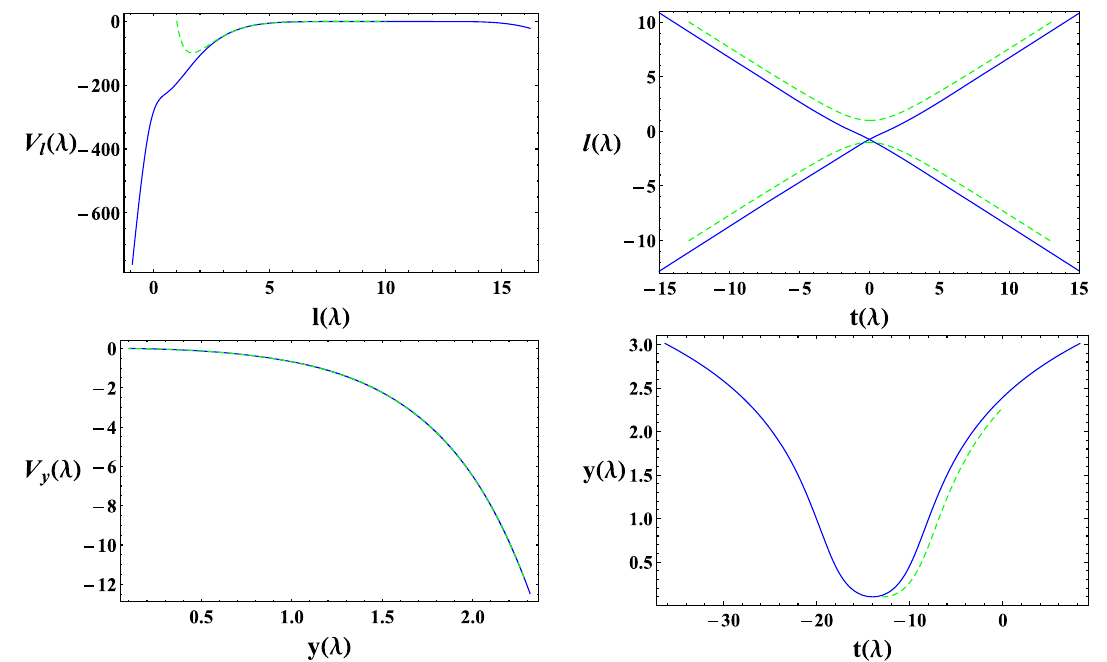
Fig. 10 Geodesics and effective potential for 5D-WEB model with decaying warp factor: dashed-green, and continuous-blue curves representing – Returning and Crossing geodesics respectively